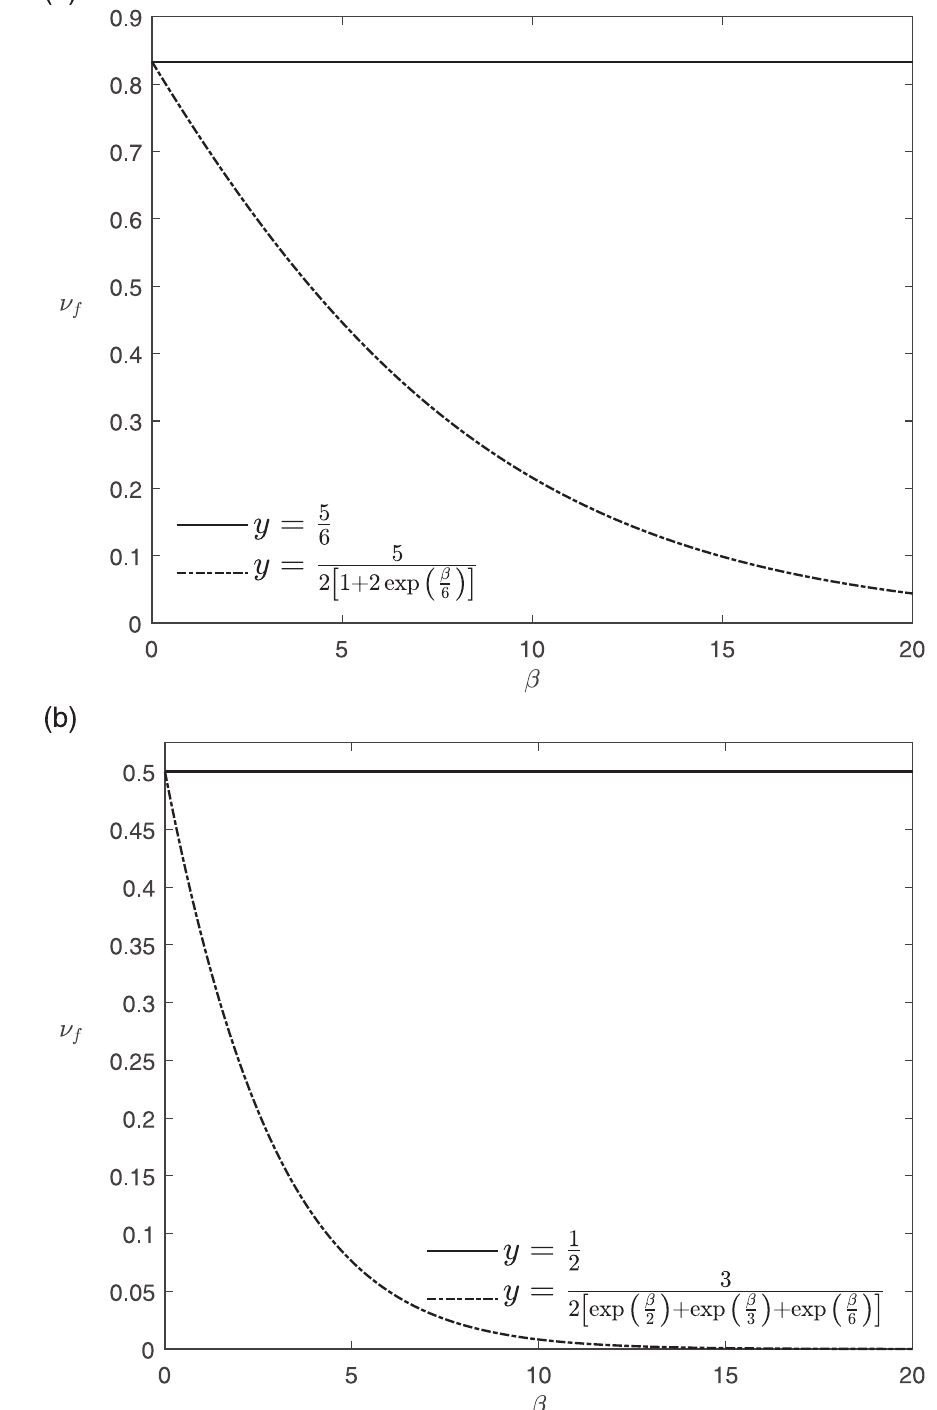
PLOS ONE | https://doi.org/10.1371/journal.pone.0253057 June 17,